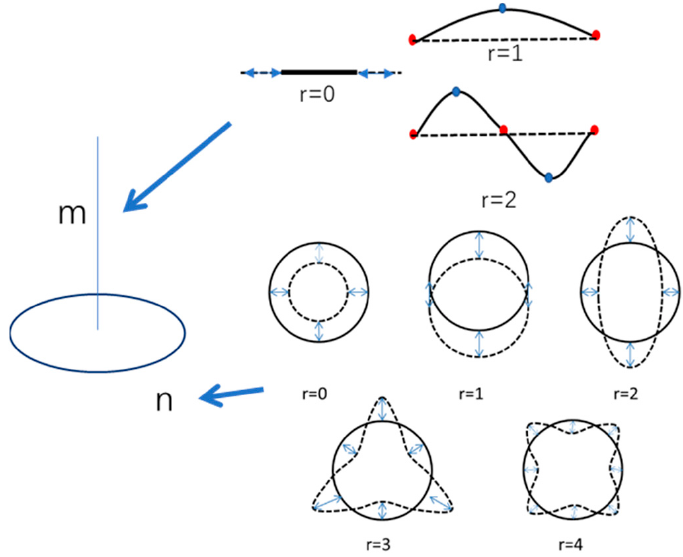
Figure 10. Definition of mode order.